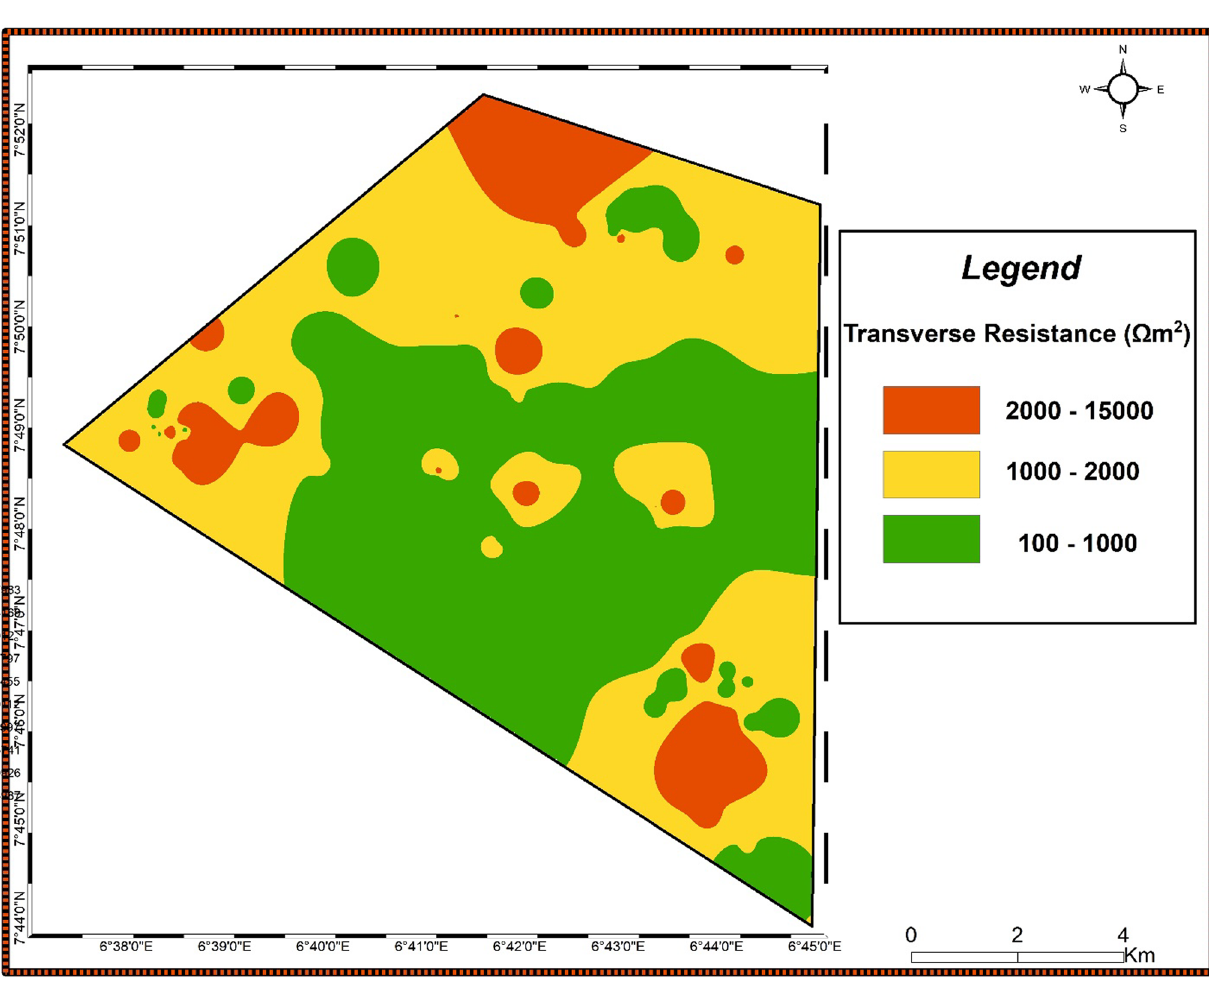
Fig. 8 Map showing the spatial distribution of transverse resistance across the study